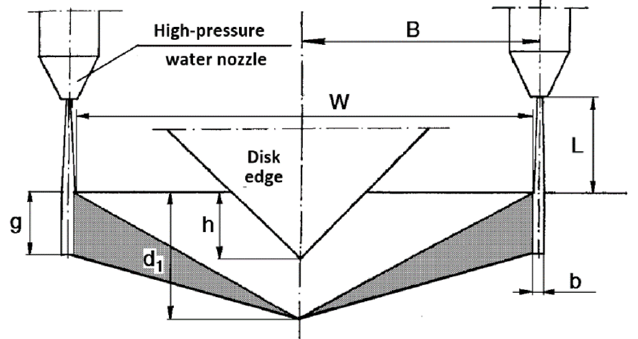
Figure 12. The diagram of mining by means of a symmetrical disk tool with assistance of HPW jets located on the sides of the disk tool [1].